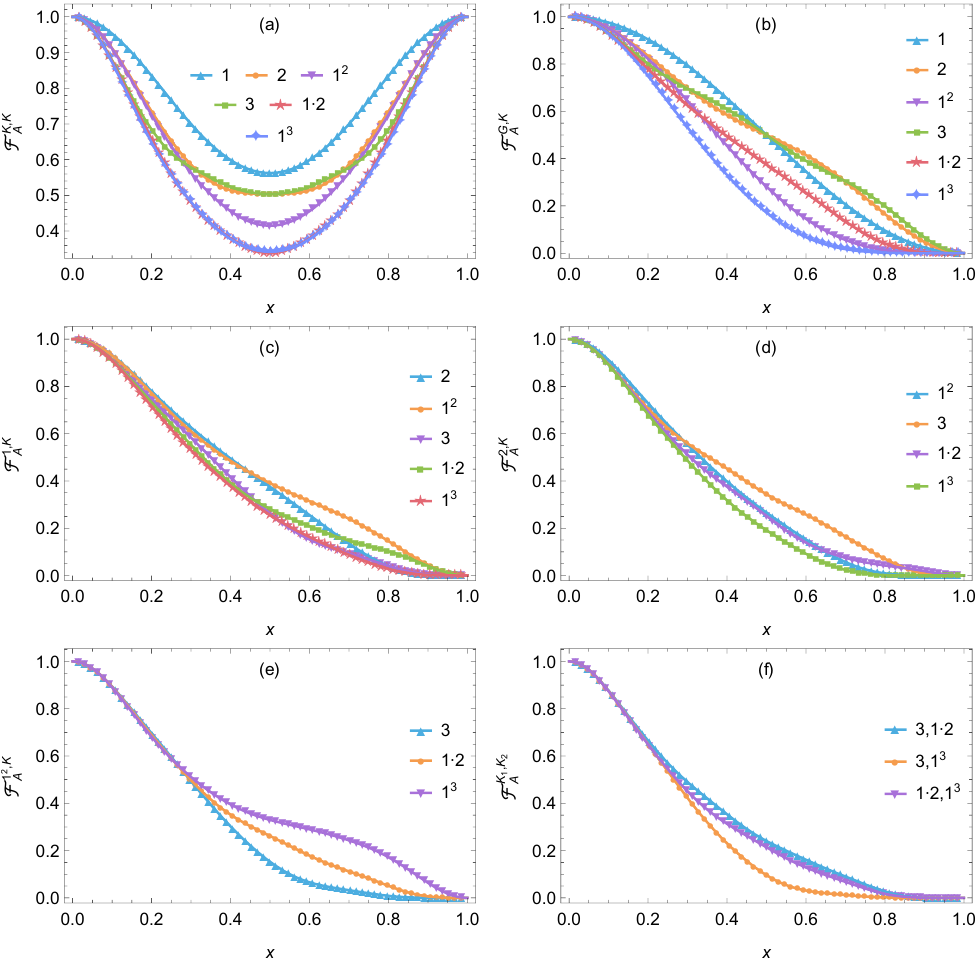
Figure 1 . The product F X 1 , X 2 (2.21) for two holomorphic operators X 1 and X 2 in the 2D free A massless non-compact bosonic theory (lines) and the corresponding quantity F K 1 ,K 2 gapless limit of the harmonic chain (symbols). We have set m = 10 − 5 , L = 64